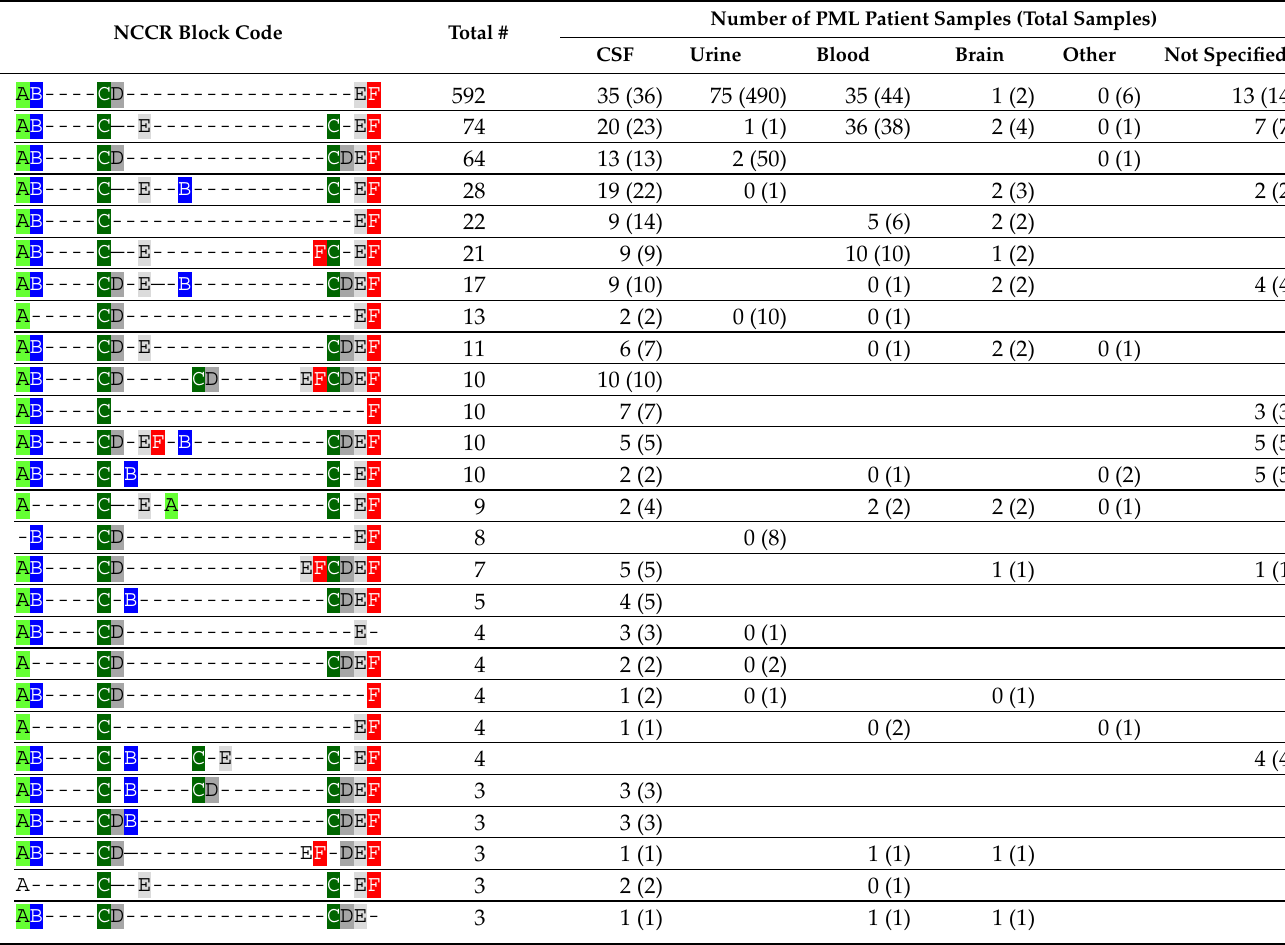
Table 2. Summary of the NCCR Block Codes by Tissue and PML Disease Status.